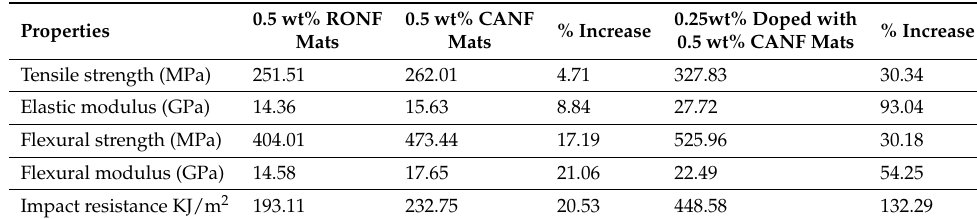
Figure 9. Mechanical properties of 0.5 wt% CANFs and 0.25 wt% f-SWCNTs doped with 0.5 wt% CANFs mats strengthened hybrid composites’: ( a ) tensile properties; ( b ) flexural properties; ( c ) impact properties. Table 5. RONF mats , CANF mats, and f-SWCNTS doped CANF mats hybrid composites properties and their